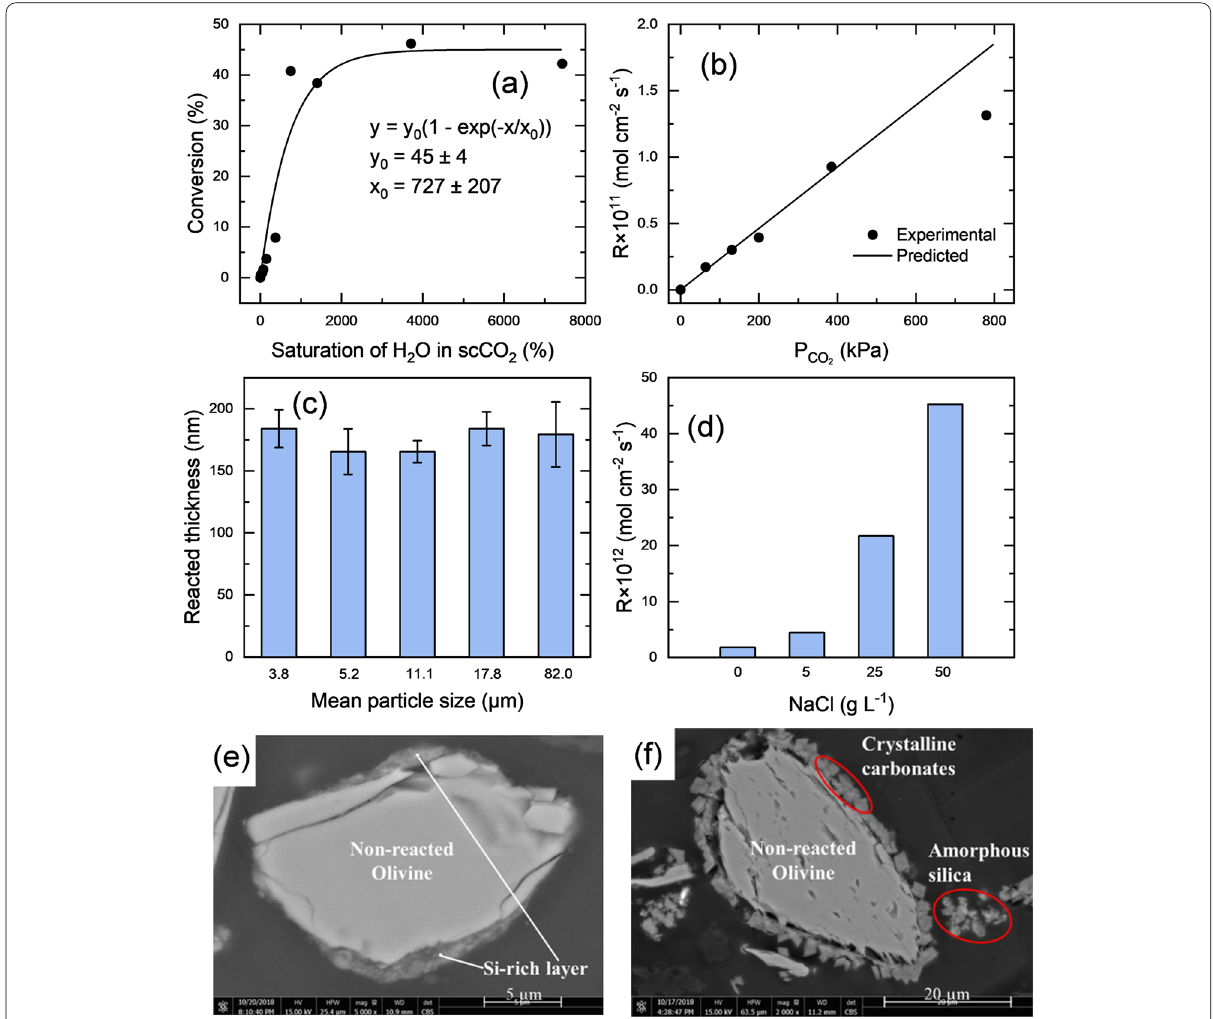
Fig. 7 a Effect of water content in scCO 2 on the conversion of forsterite (Mg 2 SiO 4 ) (Reproduced from [52] with permission from Elsevier). b The increase in partial pressure accelerated the initial dissolution rate of Mg 2 + from heat‑treated serpentine (Reproduced with permission from